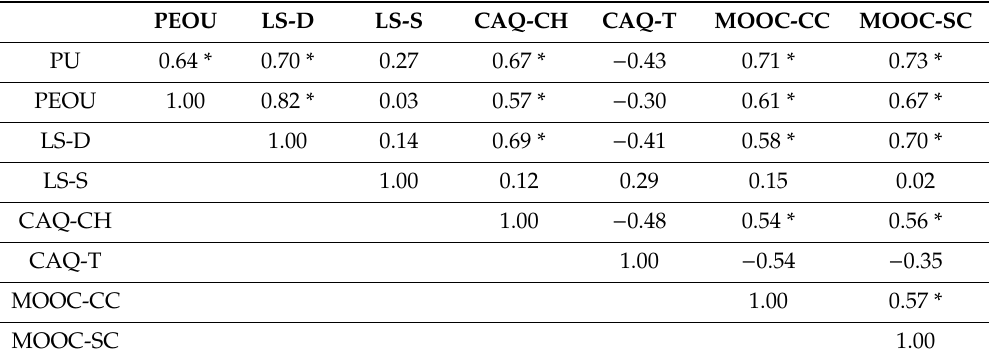
Table 3. Spearman correlation coe ffi cient (graduate